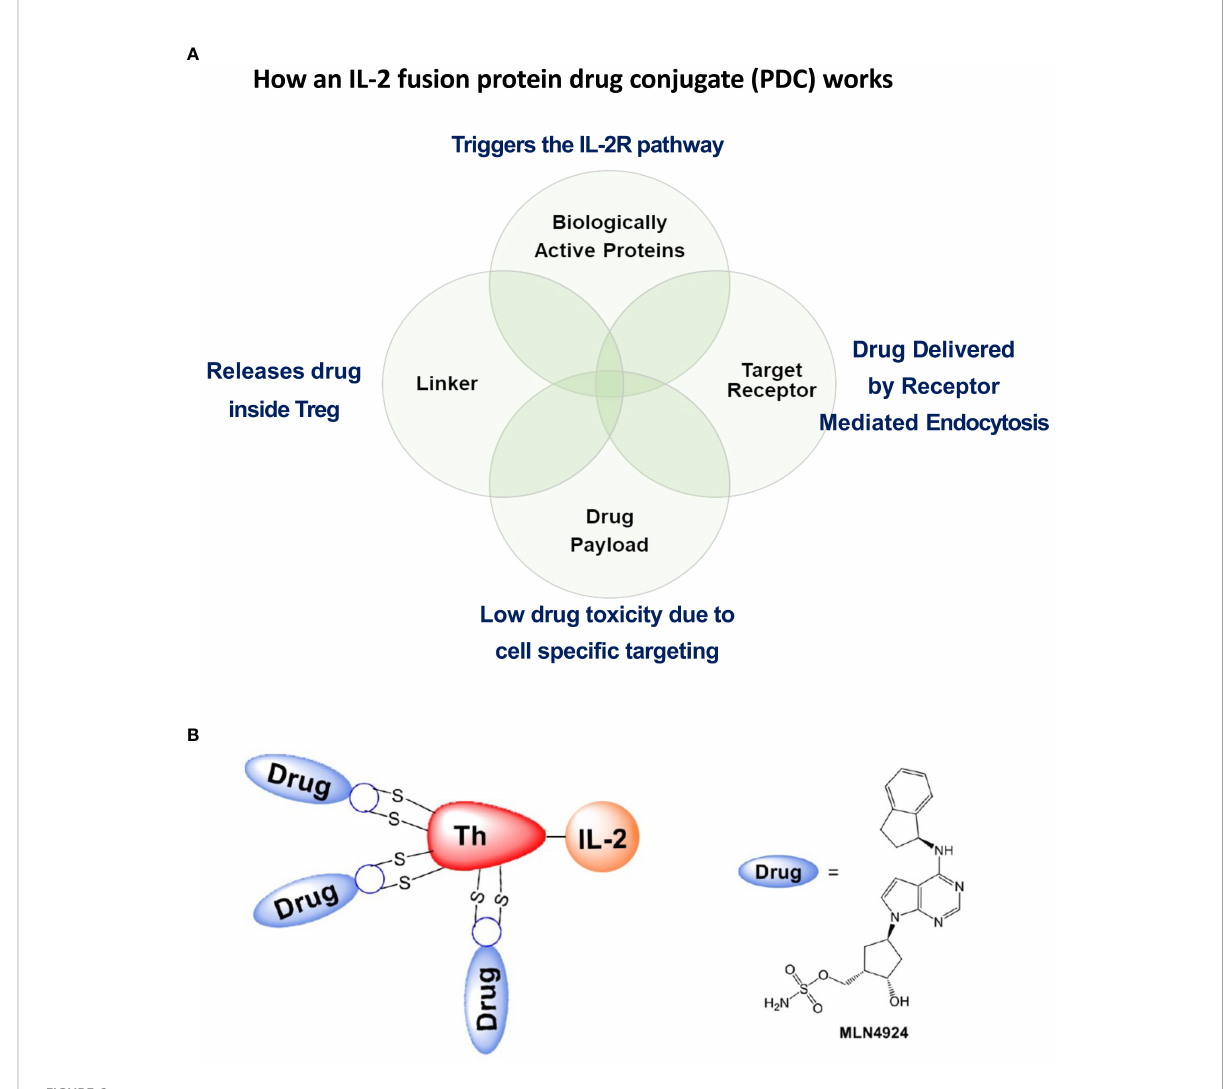
FIGURE 6 Salient features of the IL-2 fusion PDC. (A) The PDC binds to Treg cell surface IL-2R ’ s that, following PDC binding, undergo receptor mediated endocytosis. IL-2 binding to the IL-2R triggers cellular pathways leading to second messenger signaling activity. Defective second messenger signal pathways identi fi ed in Tregs from patients with autoimmune diseases that require inhibition of CRL activity, can be corrected by NAEi ’ s attached to the PDC by stable linkers that are enzymatically cleaved only inside the target cell to deliver the drug payload to the appropriate cell. (B) PDC (ATA-003) consisting of 3 molecules of an NAEi (MLN4924) bound by di-peptide linkers to the thioredoxin portion of the murine IL-2 fusion